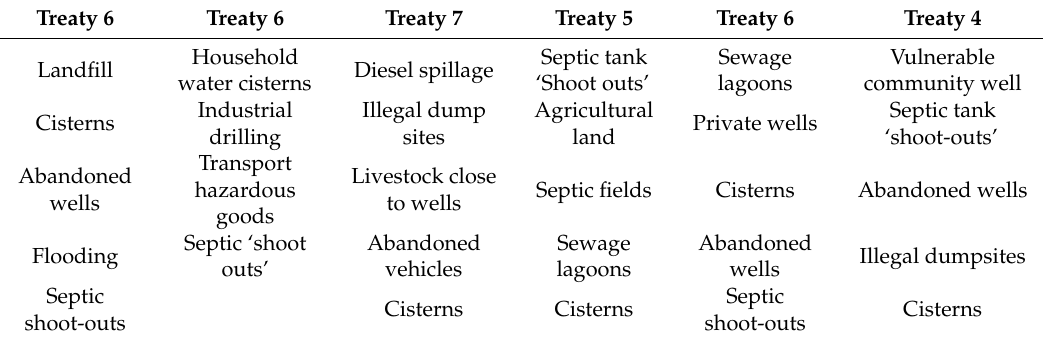
Table 2. High risk issues within selected prairie First Nations.